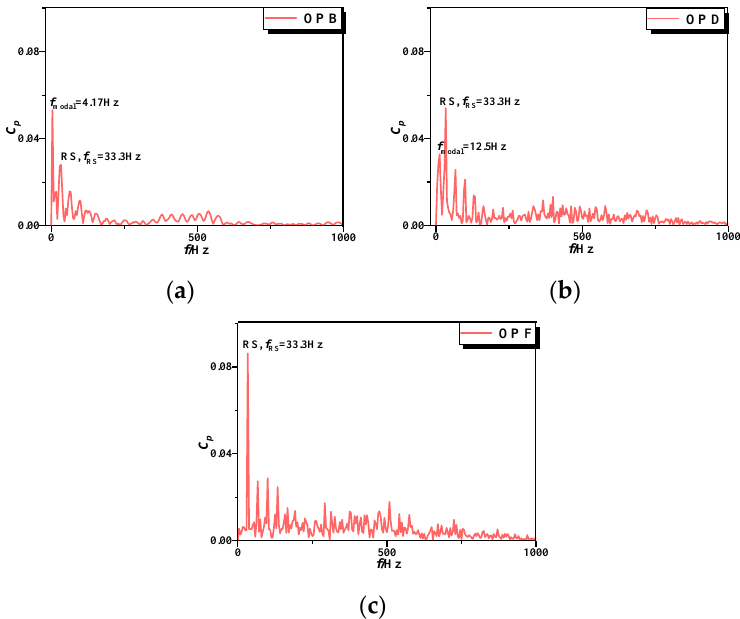
Figure 13. Spectrum chart based on FFT–OP B, D and F. ( a ) OP-B; ( b ) OP-D; ( c ) OP-F.